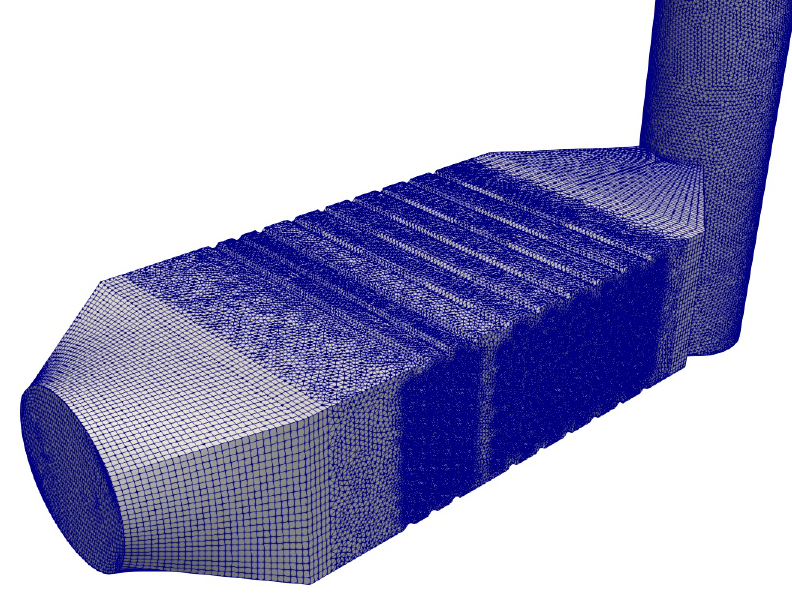
Figure 9. Fireside mesh grid for the convection-stack section.